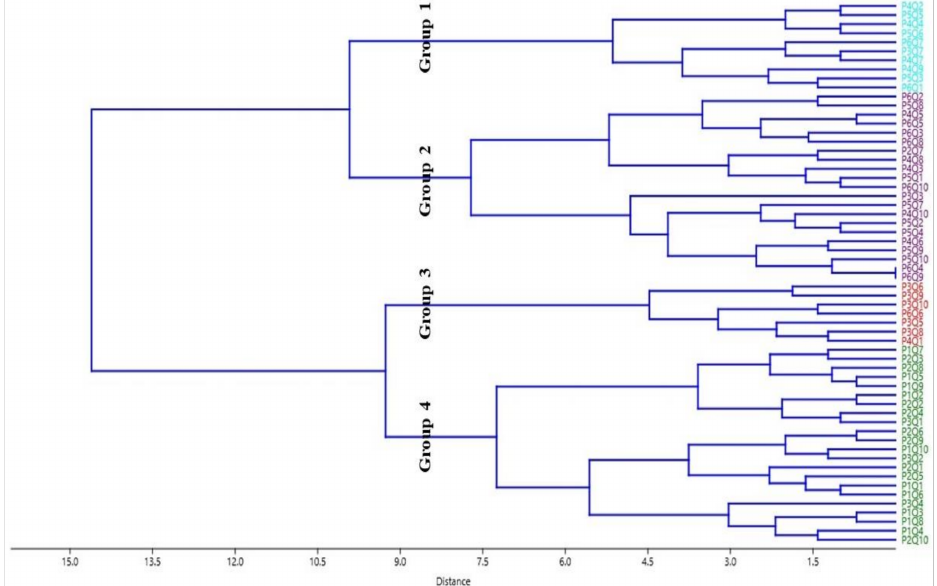
Figure 3. Four major groups of climbers in the sampling plots based on Ward’s agglomerative cluster analysis. The right side of the figure shows sampling plots. The sampling plots of group 1 are highlighted with aqua color, group 2 with purple color, group 3 with red color, and group 4 with green